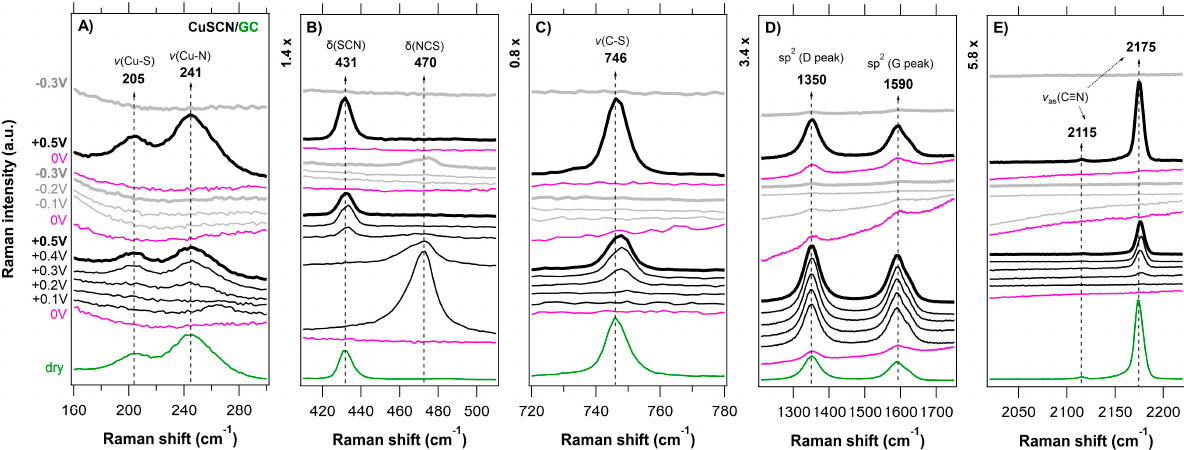
Figure 5. In situ Raman- μ SEC spectra of the CuSCN layer (spectral regions of 160–300, 410–510, 720–780, and 2020–2220 cm –1 in charts ( A ), ( B ), ( C ), and ( E ), respectively) electrodeposited on the GC substrate (spectral region of 1210–1750 cm –1 in chart ( D ) as a function of the applied potential (vs. Ag/AgCl; shown on the left-side chart) in 6 M LiCl. The measurement sequence was as follows; the first spectrum was acquired at 0 V (bottom pink trace) and the last spectrum was acquired at − 0.3 V (top gray trace). The sequence of positive potentials (from +0.1 V to +0.5 V) is visualized by black trace and the negative potentials (from − 0.3 V to –0.1 V) are visualized by the gray trace. The reference (ex situ) Raman spectrum of dry CuSCN layer on the GC substrate is shown for comparison (bottom green line). The Electrolyte solution 6 M LiCl. Spectra are offset for clarity; the intensity scale is identical for all the charts.